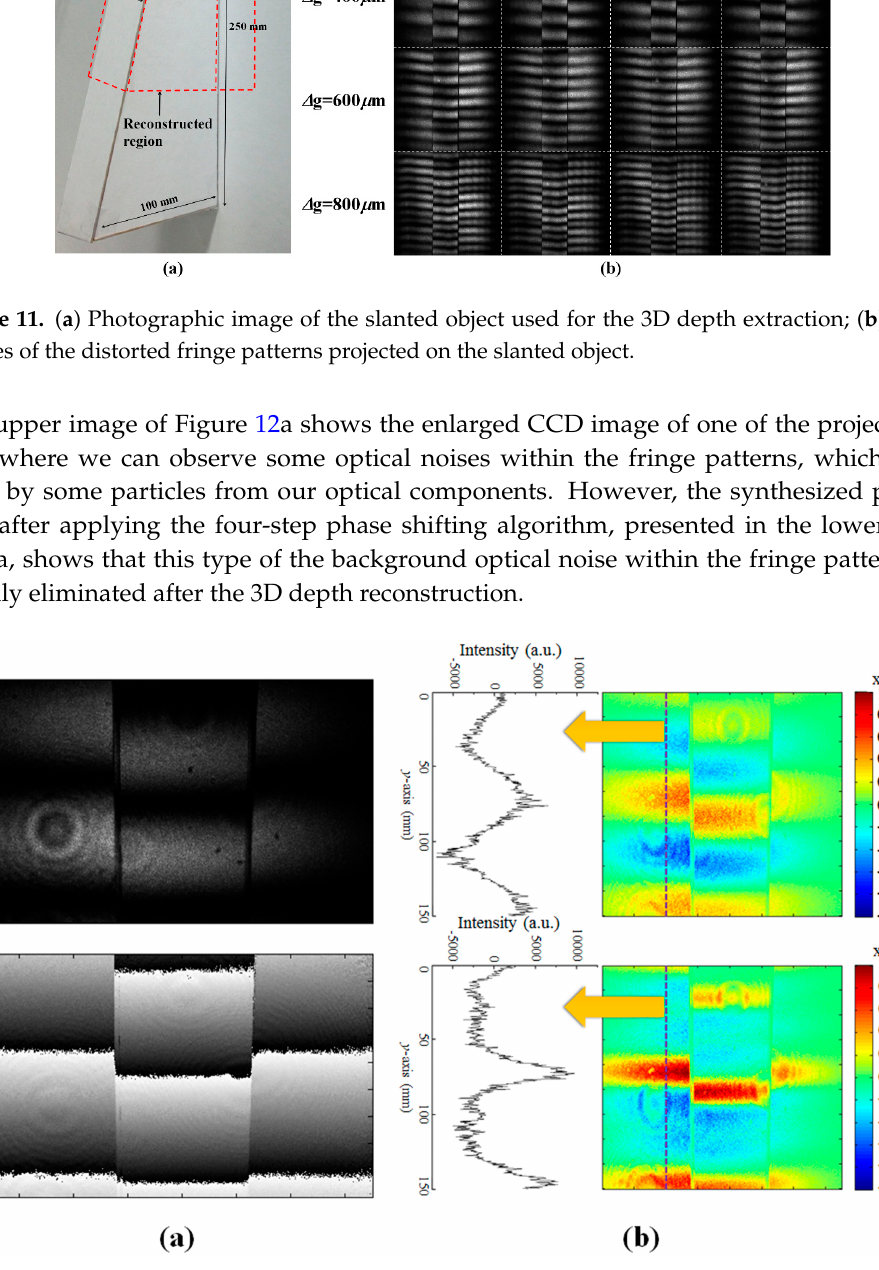
Figure 12. ( a ) Original fringe optical pattern image (upper image) projected on the slanted surface of Figure 11a using the interference slit of Δ g = 200 µm and the synthesized phase map (lower image) obtained using the four-step phase shifting algorithm; ( b ) Fictitious scanning pattern images generated from two spatial frequencies ( Δ g = 200 and 800 µm) of the projected fringe patterns (the upper images) and four spatial frequencies ( Δ g = 200, 400, 600, and 800 µm) of the projected multiple fringe patterns (lower images).